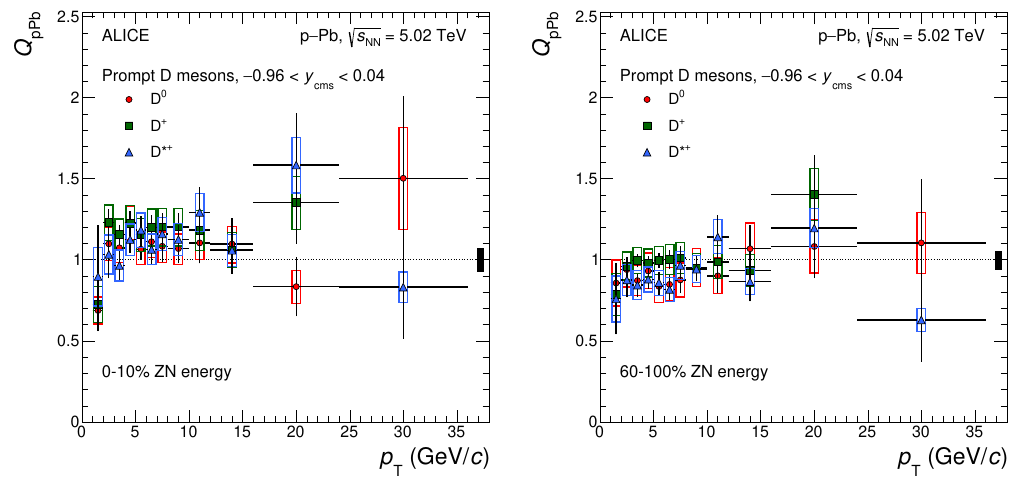
Figure 15 . D 0 , D + , and D (cid:3) + meson nuclear modi(cid:12)cation factors as a function of p T in the 0{ 10% (left) and 60{100% (right) centrality classes. The vertical bars and the empty boxes represent the statistical and systematic uncertainties. The colour-(cid:12)lled boxes at Q pPb = 1 represent the normalisation uncertainties.